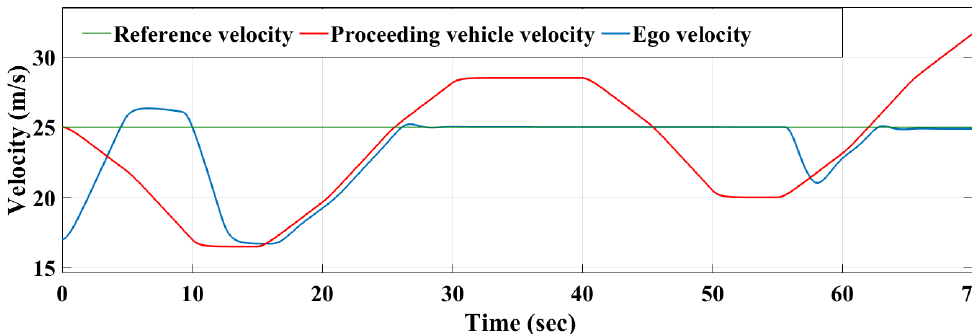
Figure 19. Velocity of ego and proceeding vehicle compared to reference velocity—RL controller.